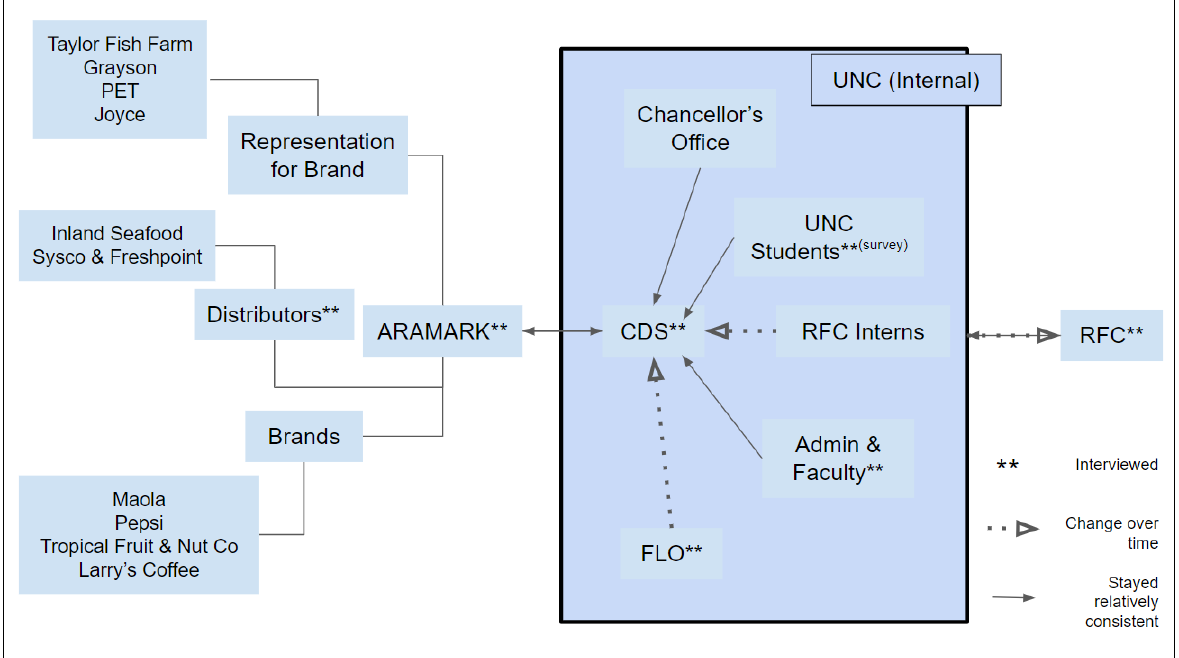
Figure 2. Visual Depiction of the Interrelationships Explored in this Study At the left side are external food producers. UNC sources from the producers listed (among others) via Aramark, which holds the contract with UNC to run the dining halls. The middle of the graphic, in the blue square, shows groups internal to UNC. The dotted arrows indicate that we noted considerable change over time in the nature of those relationships. The far right side of the graphic shows RFC: the double-sided arrow represents that from RFC’s perspective, the relationship with UNC has stayed consistent. From UNC’s perspective, the relationship with RFC has